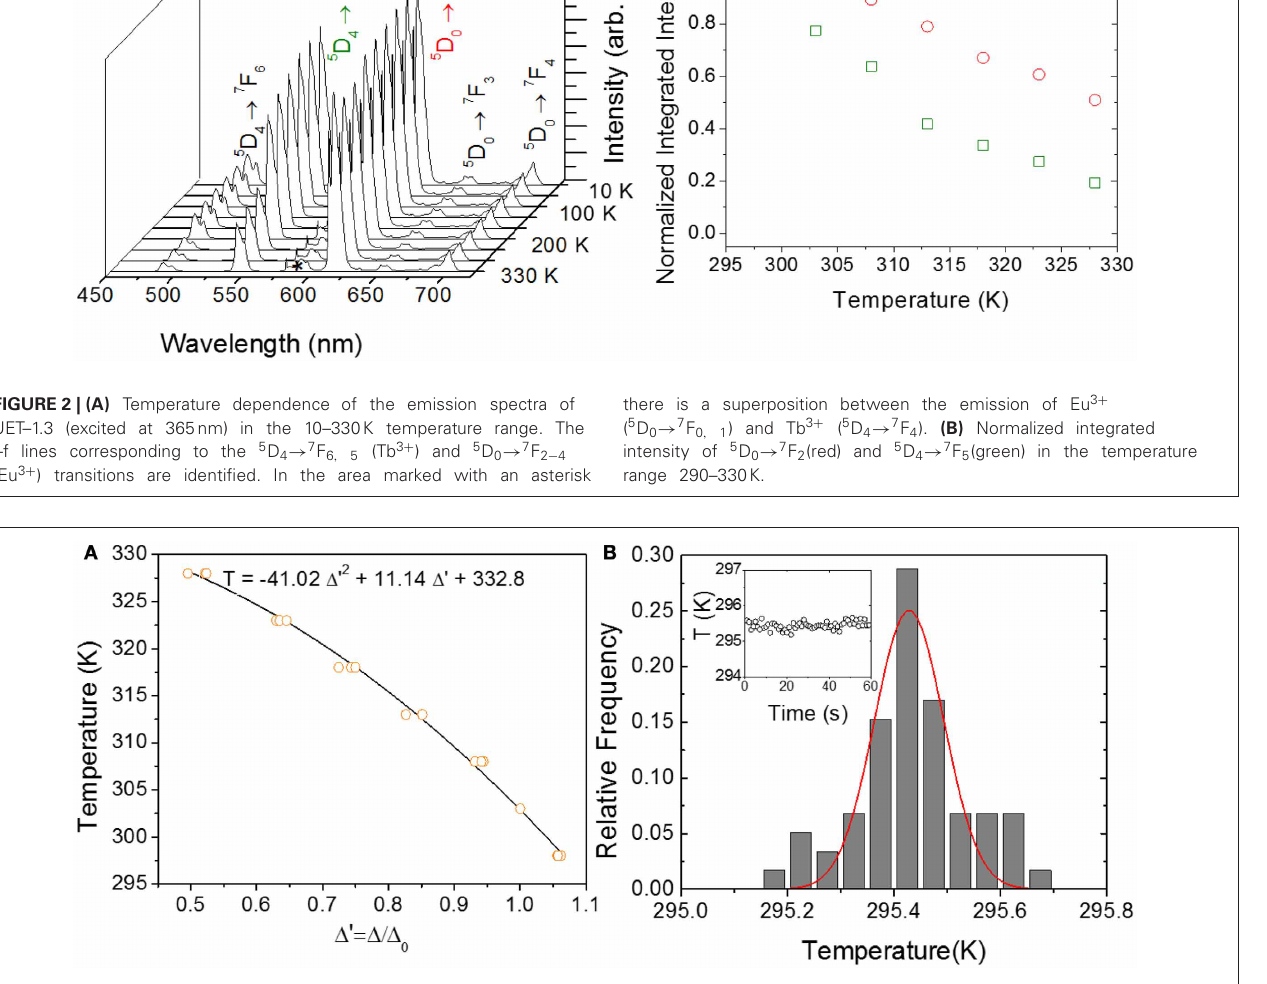
FIGURE 3 | (A) Local calibration curve of UET–1.3 for the temperature range 290–330K. The temperature was cycled three times and the emission spectra recorded at equal time intervals when the temperature increases. For all emission spectra the computed (cid:2) parameter was divided by its value at 303K ( (cid:2) 0 ) to get a thermometric parameter near the unit. The results for all cycles are overlapped and the second